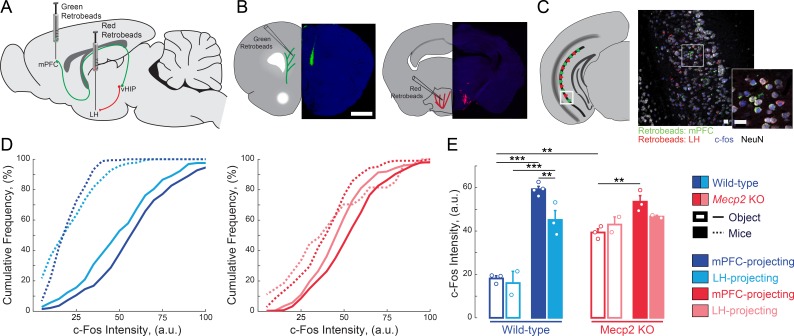
mPFC-projecting vHIP neurons are selectively activated during sequential social encounters with familiar and novel mice.(A) Schematic of RetroBead injection for labeling mPFC- or LH-projecting vHIP neurons. (B) Injection sites. Scale bar 1 mm. (C) RetroBead labeling and c-Fos immunohistochemistry in vHIP sections. Scale bar 25 μm. (D) Cumulative probability distributions of c-Fos intensities of RetroBead-labeled neurons [n = 163 cells from 3 sections from three mice (163/3/3) WT mPFC-projecting with toy mice; n = 180/3/2 WT LH-projecting with toy mice; n = 275/6/4 WT mPFC-projecting with live mice; n = 271/4/3 WT LH-projecting with live mice; n = 105/6/3 Mecp2 KO mPFC-projecting with toy mice; n = 22/3/2 Mecp2 KO LH-projecting with toy mice; n = 247/4/3 Mecp2 KO mPFC-projecting with live mice; n = 172/5/2 Mecp2 KO LH-projecting with live mice]. (E) Mean c-Fos intensity of RetroBead-labeled neurons, averaged per mouse. [WT mPFC toy mice vs. WT LH toy mice, p 0.6463; WT mPFC toy mice vs. WT mPFC live mice, p<0.0001; WT LH toy mice vs. WT LH live mice, p<0.0001; WT mPFC live mice vs. WT LH live mice, p=0.0022; KO mPFC toy mice vs. KO LH toy mice, p=0.4612; KO mPFC toy mice vs. KO mPFC live mice, p=0.0034; KO LH toy mice vs. KO LH live mice, p=0.4885; KO mPFC live mice vs. KO LH live mice, p=0.1544; WT mPFC toy mice vs. KO mPFC toy mice, p=0.0001; WT mPFC live mice vs. KO mPFC live mice, p=0.1544; Projection p=0.0292; Genotype p<0.0001; Experience p<0.0001; Projection x Genotype p=0.1263; Genotype x Experience p<0.0001; Projection x Genotype x Experience p=0.8545; Three Way ANOVA with Benjamini and Hochberg Multiple Comparisons]. Mean ± SEM; *p<0.05, **p<0.01. Figure 1—source data 1. See also Figure 1—figure supplement 1.10.7554/eLife.44182.005Figure 1—source data 1.mPFC-projecting vHIP neurons are selectively activated during sequential social encounters with familiar and novel mice.